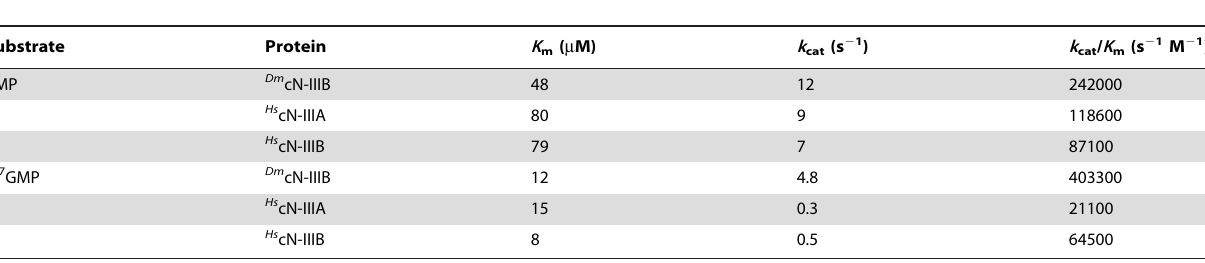
Table 2. Kinetic properties of the cytosolic 5 9 -nucleotidases IIIA and IIIB.